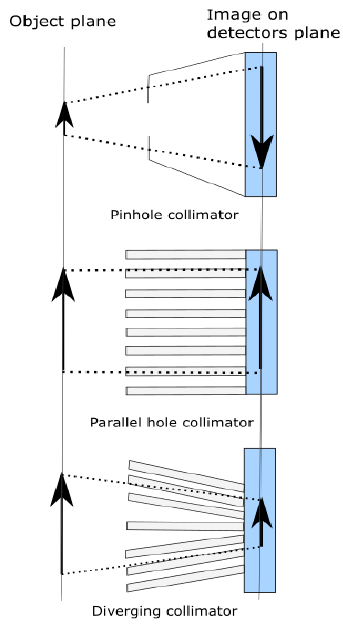
Figure 4. Schematic of physical collimator types.